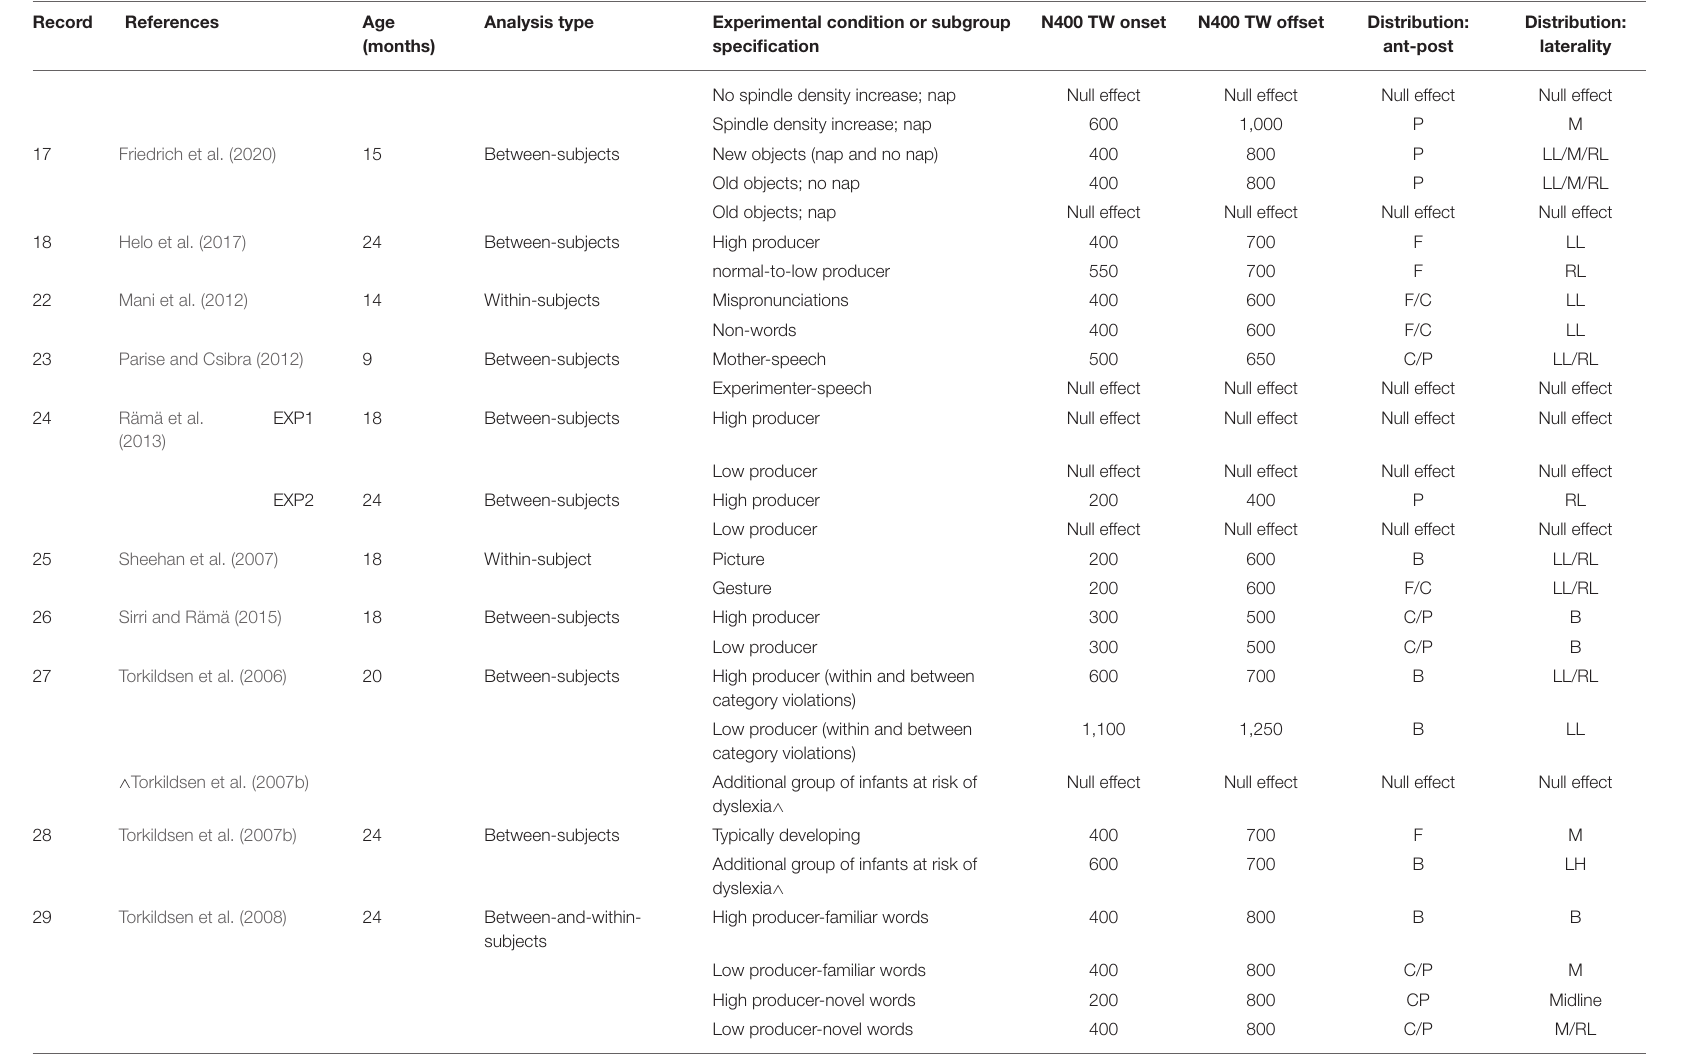
Studies are sorted by the original record that published findings (see Table 1 ); the second column with Author and publication lists the source in which the subgroups or within-subjects are analyzed. * Results from a single TW interaction; ∧ Results published in an additional paper. TW,timewindow;DistributionAnt/Post,Anterior-Posterioraxis{B,broad;C,central,F,frontal,P,parietal};distributionlaterality-axis{LL,left-lateralized;RL,right-lateralized;ML,midline;B,broad};FH,familialriskoflanguageimpairments; L.I., language impairments Table 1